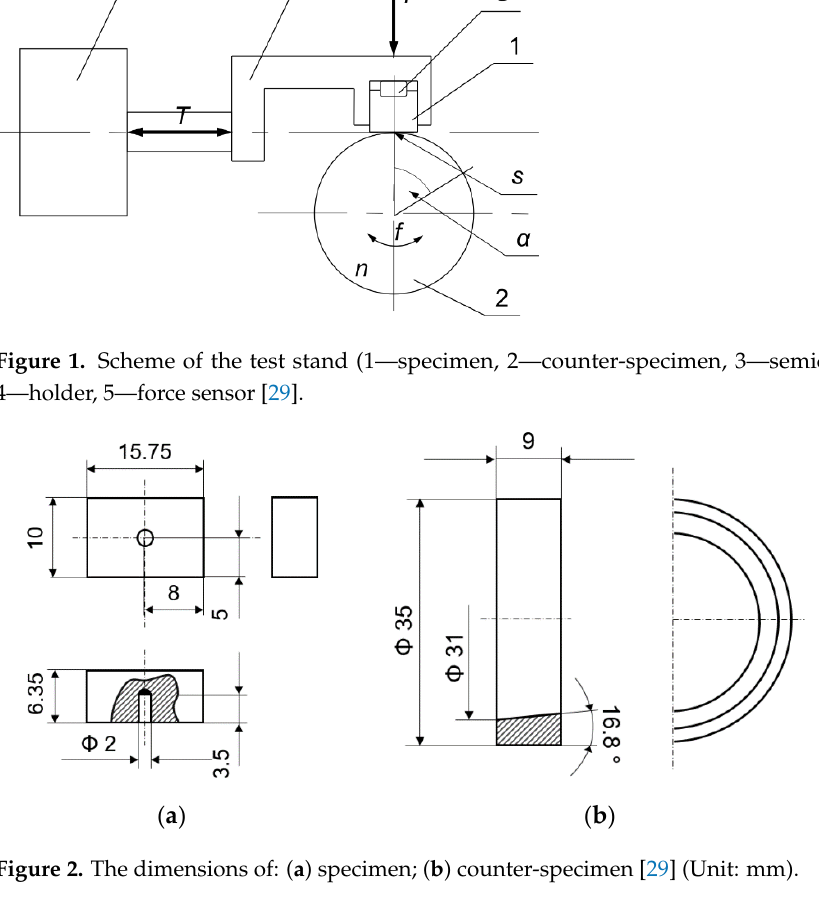
Figure 1. Scheme of the test stand (1 — specimen, 2 — counter-specimen, 3 — semicircular canopy, 4 — 144 holder, 5 — force sensor [29]. 145